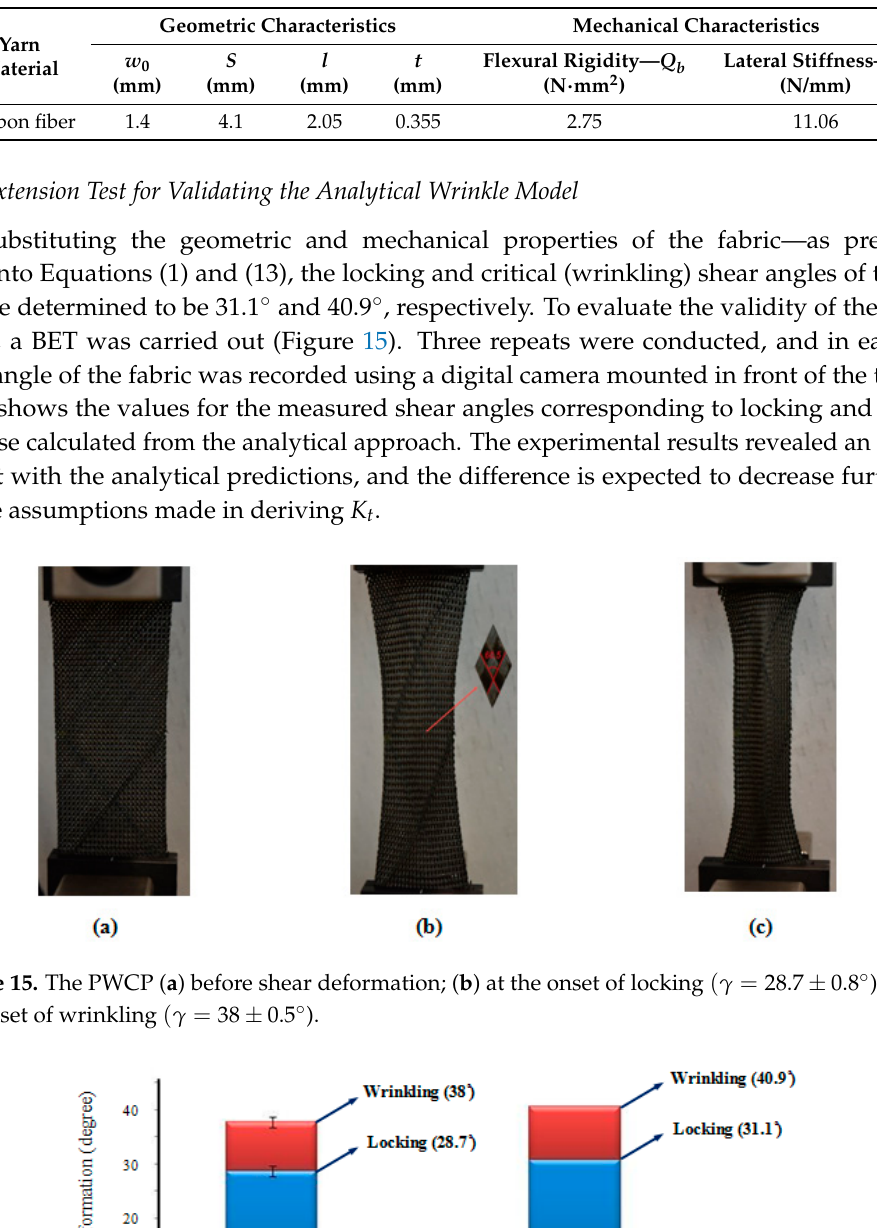
Table 1. Summary of the measured geometric and mechanical characteristics of the PWCP.